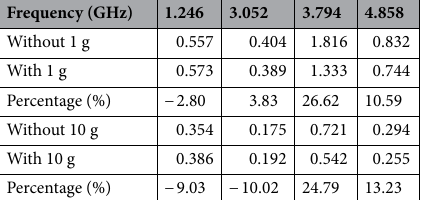
Table 9. Array metamaterial position